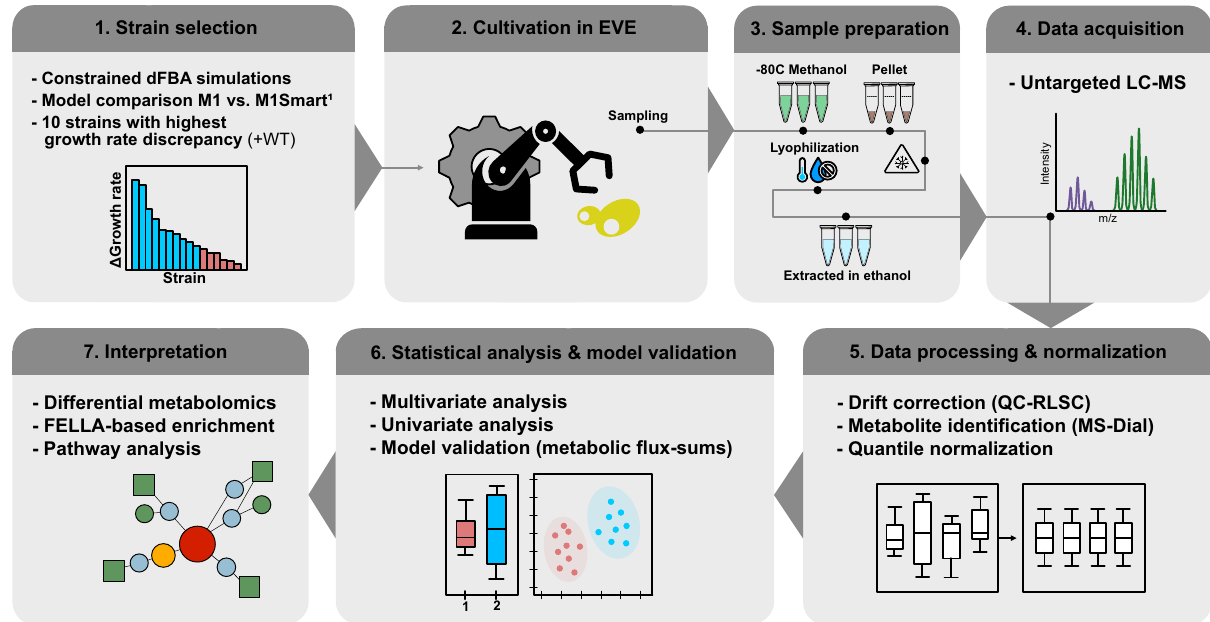
Fig. 5 Overview on the work fl ow and protocols used in this study. 1 Simulations were performed according the framework supplied in Coutant et al. and the comparison between the models served as the basis for strain selection 4